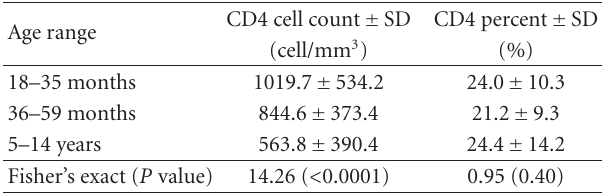
Figure 1: Treatment with HAART by clinical disease severity and degree of immunosuppression. Table 2: Mean CD4 cell count and mean CD4% of the subjects by